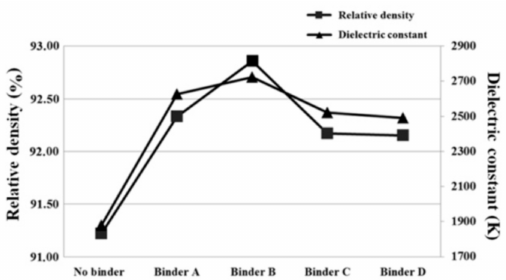
Figure 6. Relative densities and dielectric constants of the 0.1 wt.% Dy 2 O 3 -doped 0.98BaTiO 3 - 0.02(Ba 0.5 Ca 0.5 )SiO 3 specimens sintered at 1320 ◦ C for 1 h with different